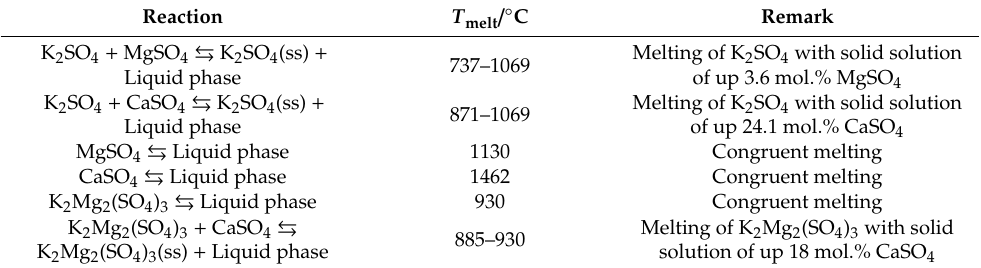
Table 2. Summary of the optimized temperatures of melting and eutectic reactions in the K 2 SO 4 -(Mg, Ca)SO 4 system. Decimals are rounded to the nearest whole number and a cumulative error range is ±4 °C.